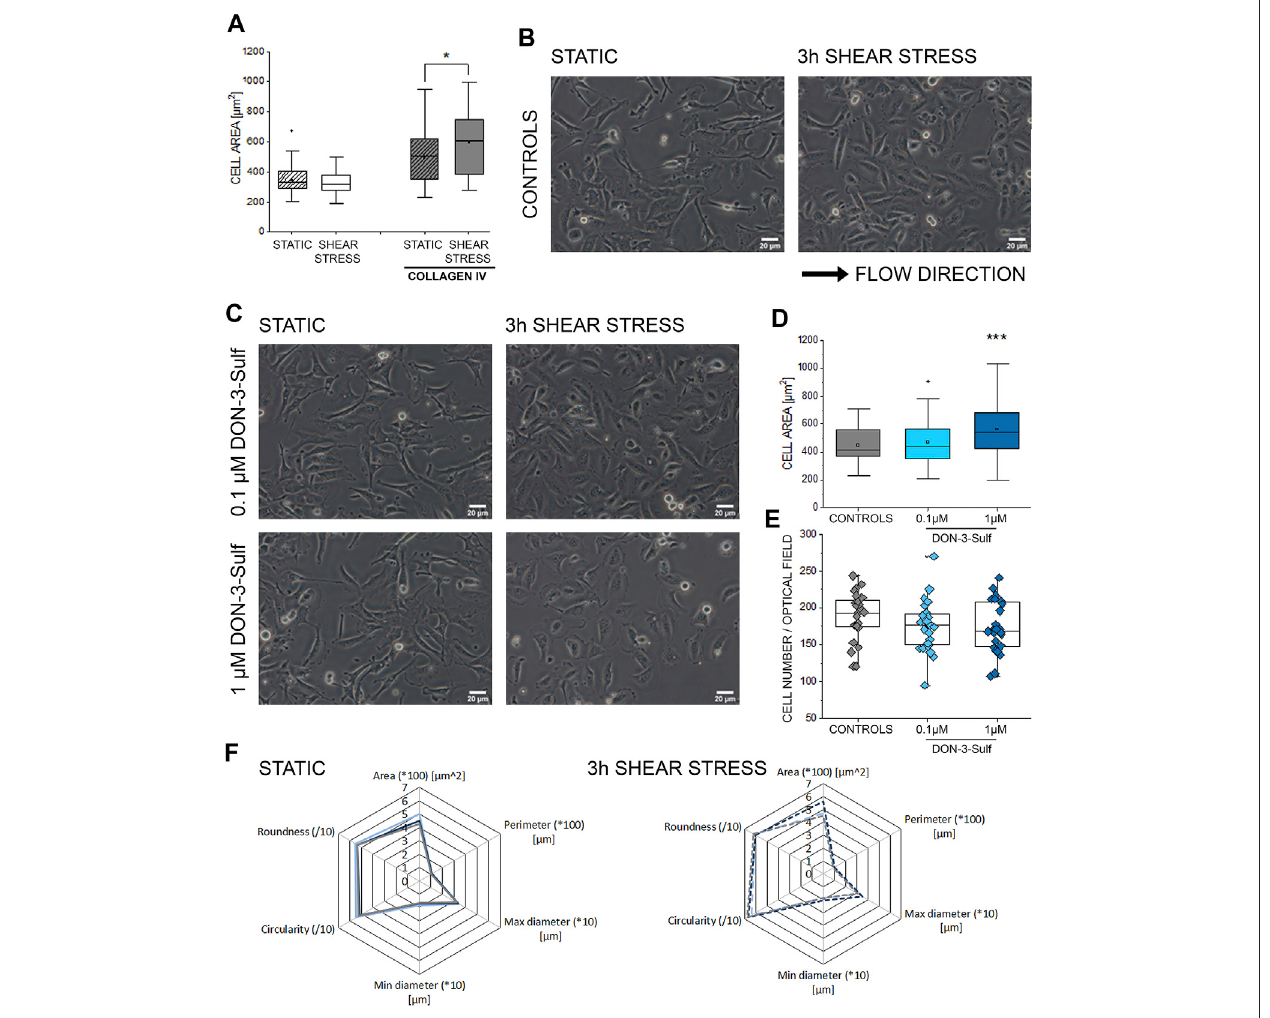
FIGURE 3 | Response of T24 to shear stress stimulation. (A) Quanti fi cation of area spread after biomechanical stimulation. (B) Bright fi eld appearance of T24 cells in static conditions and after 3 h shear stress on collagen IV extracellular matrix. (C) Bright fi eld appearance of T24 cells after incubation with DON-3-Sulf 0.1 – 1 µM. (D) Area distributionofcellsaftershearstressstimulationprotocol. (E) Theaveragecellnumberperoptical fi eld. (F) Multiparametricmorphologicalevaluationofcellscultivatedinstatic conditions and after biomechanical stimulation. Controls in gray, DON-3-Sulf in light blue (0.1 µM) and dark blue (1 µM). Morphometric data are mean of n (cid:1) 75 cells randomlyselectedandquanti fi ed.*indicatessigni fi cantdifferenceincomparisontocontrolsattheStudent ’ s t -test(*: p ≤ 0.05;**: p ≤ 0.01;***: p ≤ 0.001;scalebar:20 µm).